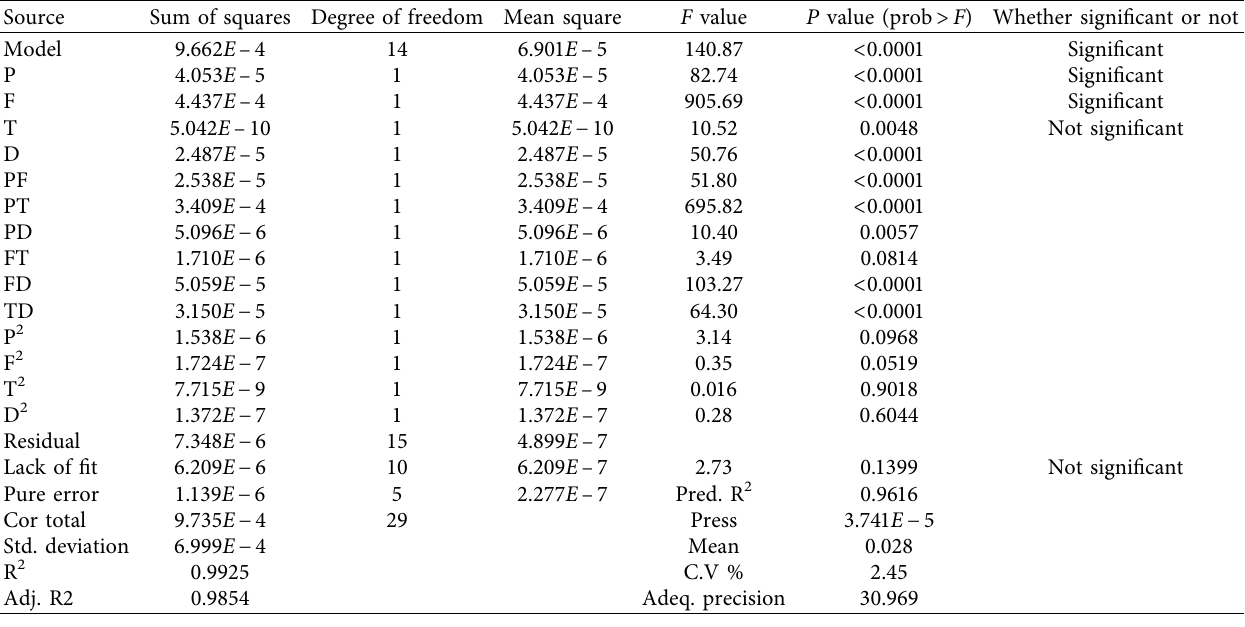
Table 7: ANOVA test results.